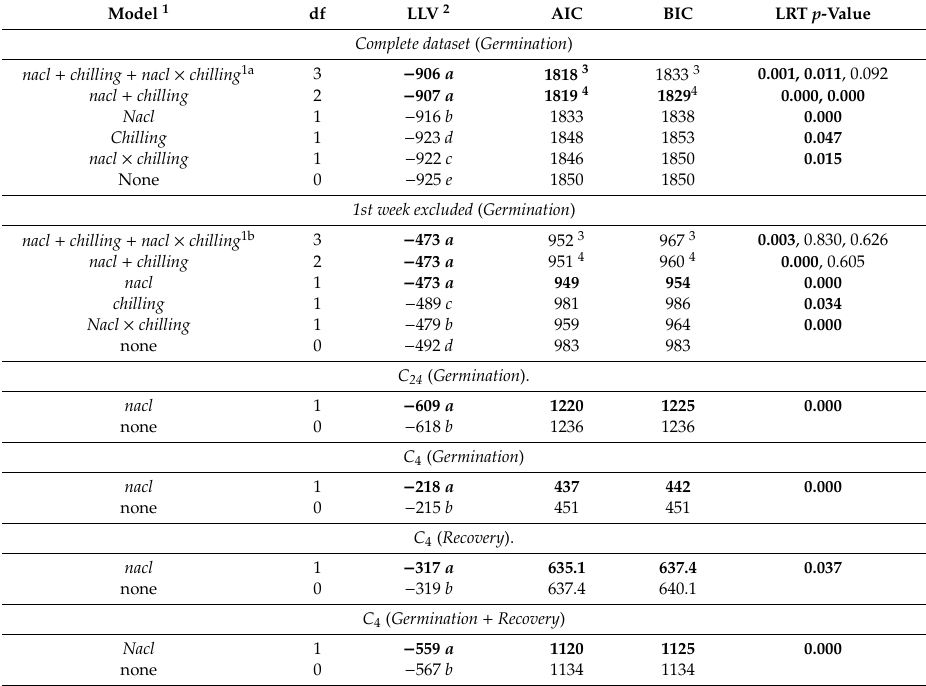
from model. Complete dataset (Germination) : nacl × chilling , 1819 (1829); chilling , 1823 (1833); nacl , 1823 (1838). 1 st week excluded (Germination) dataset: nacl × chilling , 951 (961); chilling , 950 (960); nacl , 959 (960). 4 AIC (BIC) values after single term drop from model. Complete dataset (Germination) : chilling , 1833 (1838); nacl , 1848 (1852). 1st week excluded (Germination) dataset: chilling , 949 (954); nacl , 981